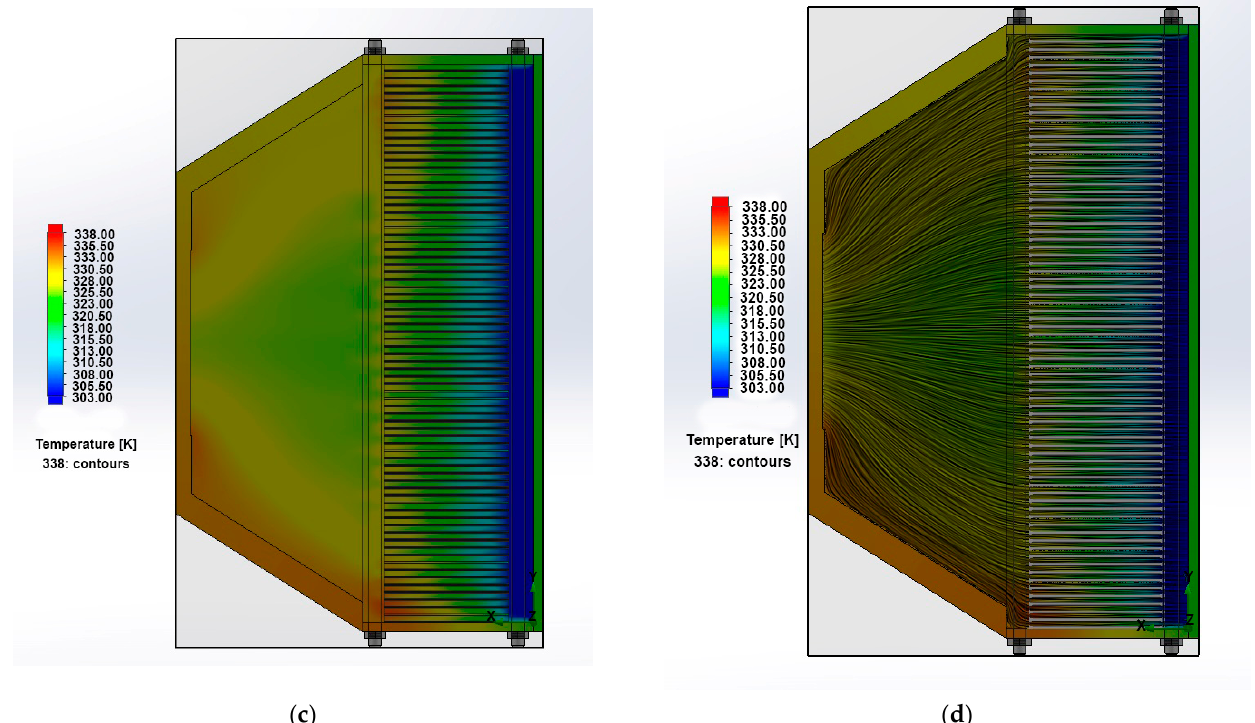
Figure 6. The temperature fields in the cross section ( a ) at the entry and ( b ) at the exit, ( c ) in the longitudinal section from the PEMFC stack; ( d ) the particle flow trajectories in the longitudinal section of the PEMFC stack.